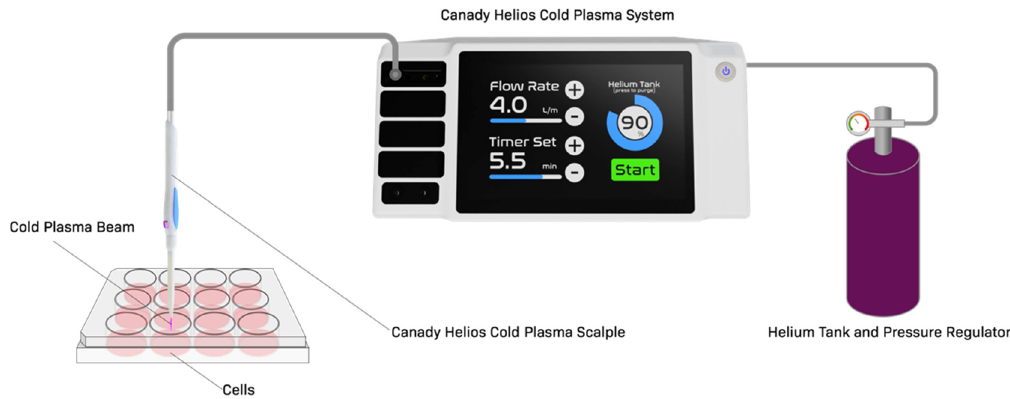
Figure 1. Schematic image of Canady Helios Cold Plasma setup for the treatment of breast cancer cells.